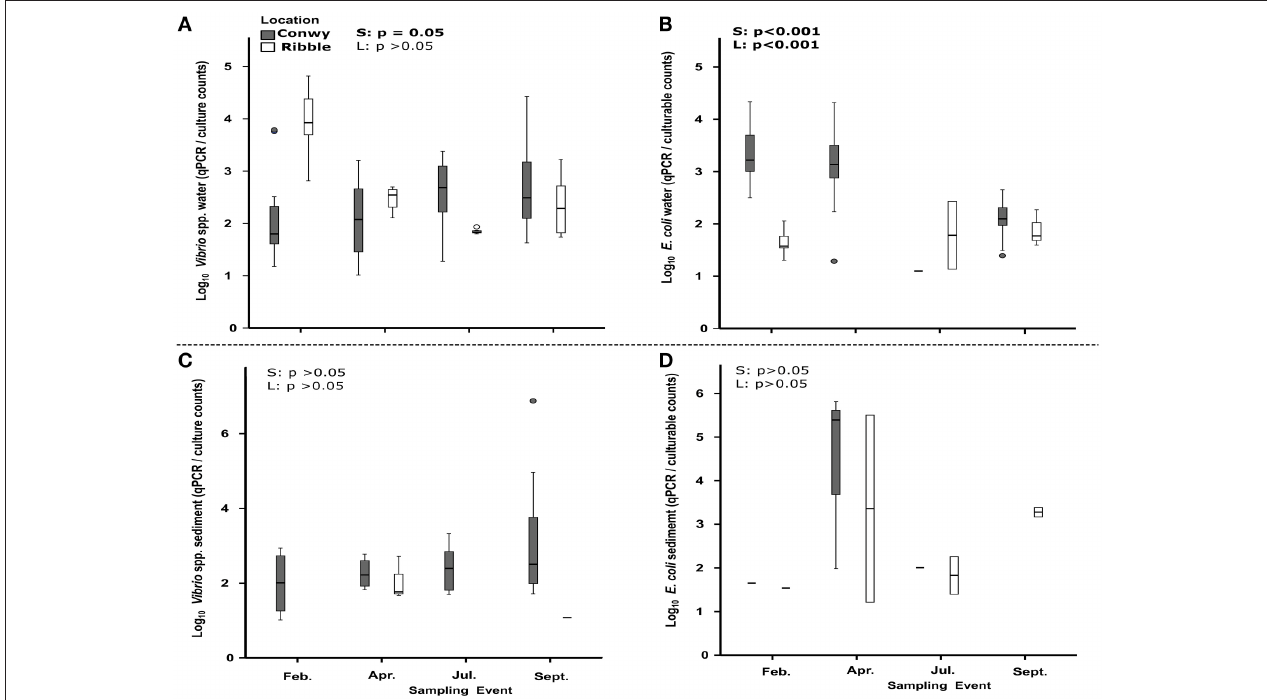
FIGURE 6 | Non-culturability index (qPCR/colony counts) for Vibrio (A,C) and E. coli (B,D) in water and sediments. Site data are pooled for each sampling event. Boxes represent 25–75 percentiles and median value (thick black line). Whiskers represent the minimum and maximum data. Outliers and extreme values are plotted as circles and stars respectively. Sites which had a non-culturability index < 1 are excluded from analysis. Statistical results of Welch’s t -test are presented within graphs, with S, effect of season; L, effect of location (Conwy and Ribble). Significant results are in